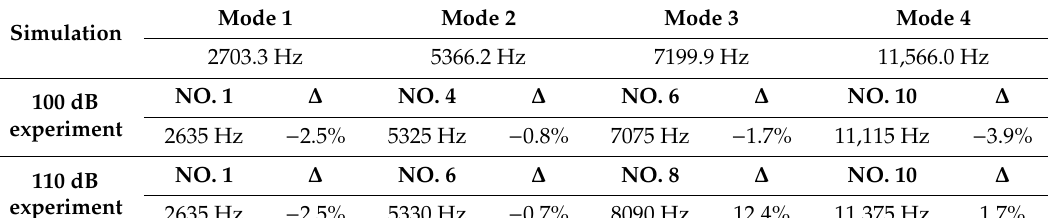
Table 3. Comparison of simulation and experiment results.